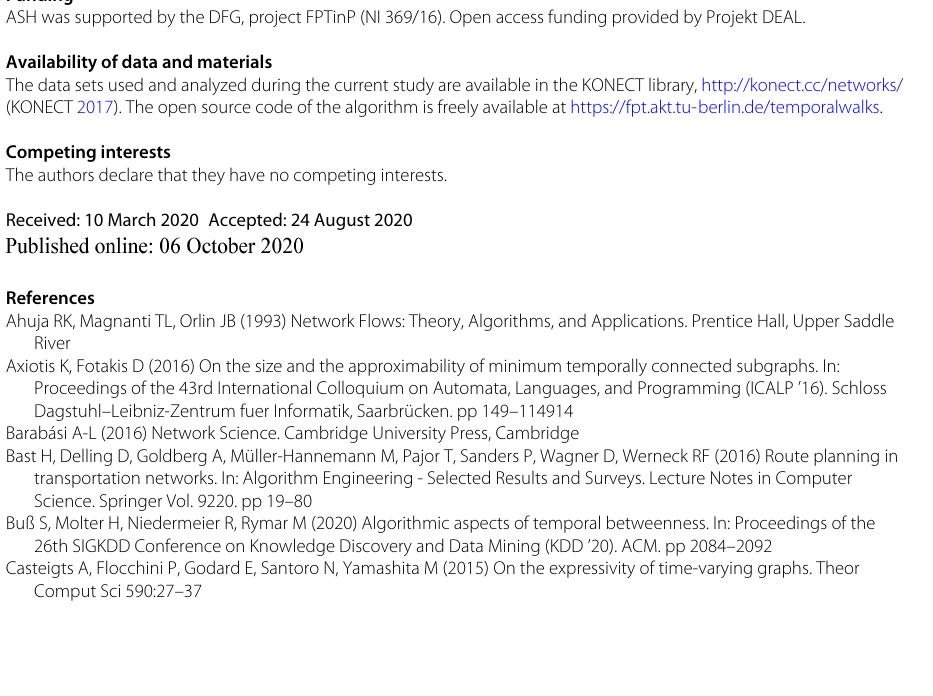
optimization criteria counting temporal paths is computationally hard even without wait- ing time constraints; in contrast, counting temporal walks seems easier (Rad et al. 2017; Buß et al.